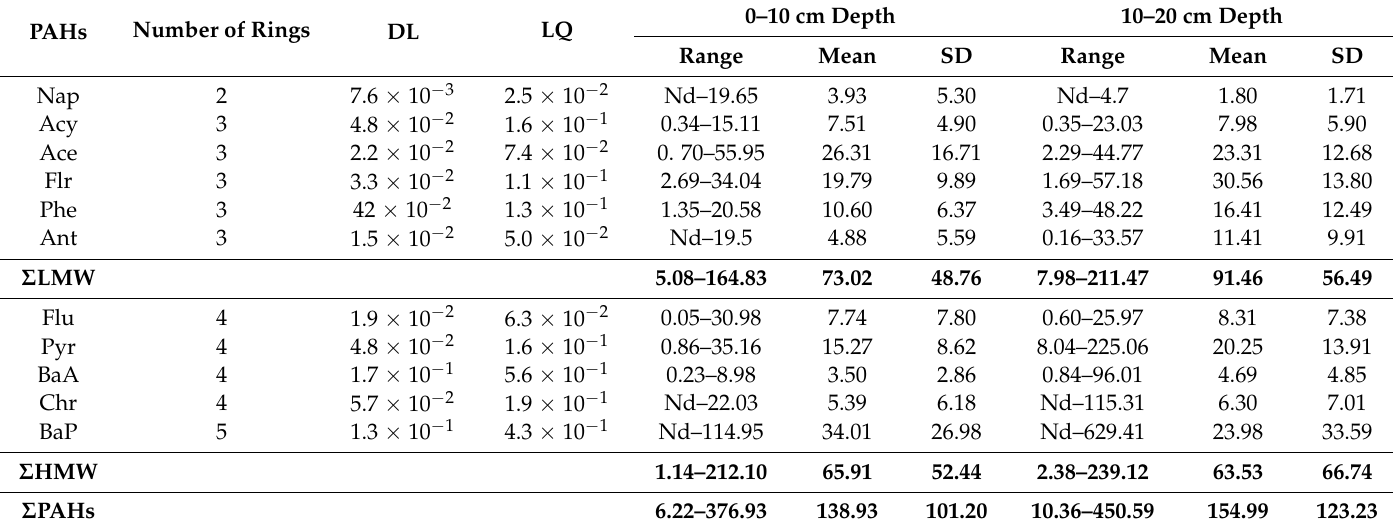
Table 2. Concentrations, limits of detection (DL), and limits of quantification (LQ) of PAHs ( µ g kg − 1 ) at depths of 0–10 and 10–20